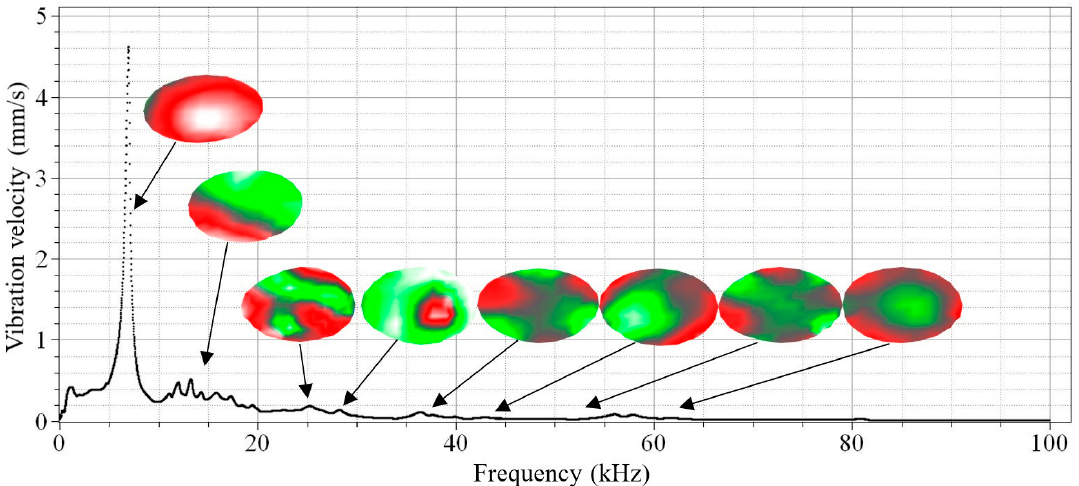
Figure 5. Amplitude–frequency vibration spectrum in the center of aluminum membrane at frequency range from 50 Hz to 100 kHz; 3400 lines; and 30 Hz frequency resolution.